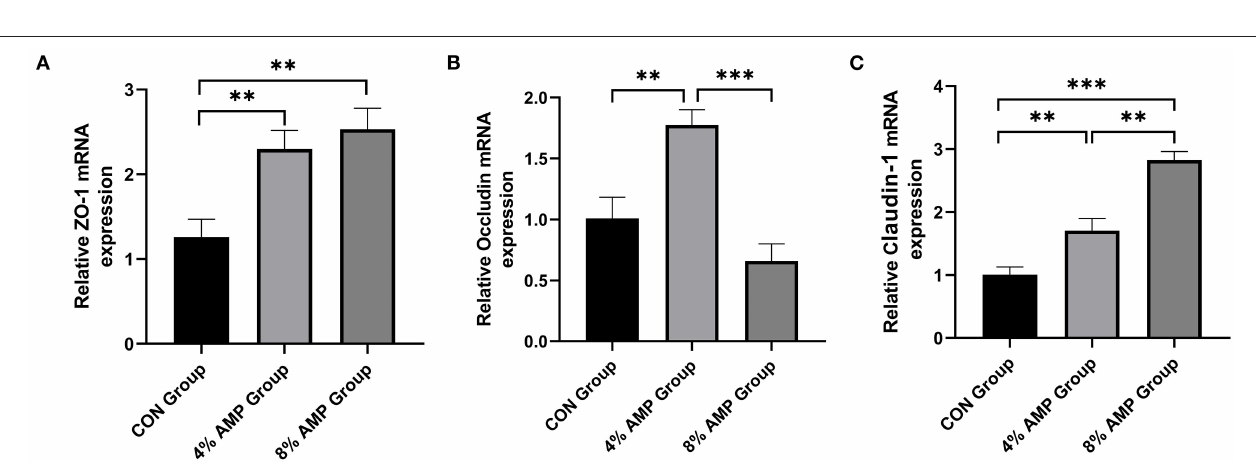
FIGURE 5 | Effect of dietary AMP supplementation on the expression of genes related to intestinal barrier function in pigs. (A) mRNA expression of zonula occludens protein-1 (ZO-1); (B) Occludin; (C) Claudin-1. Data are expressed as the means ± SDs, n = 6, * P < 0.05, ** P < 0.01, *** P < 0.001. have anti-inflammatory effects, help maintain the integrity of the colon. Propionic acid is produced mainly by Bacteroidetes the mucosal barrier, are associated with the regulation of the (43), and butyric acid is produced mainly by Firmicutes , immune response, help maintain the homeostasis of providing a metabolic energy source for intestinal cells. SCFAs